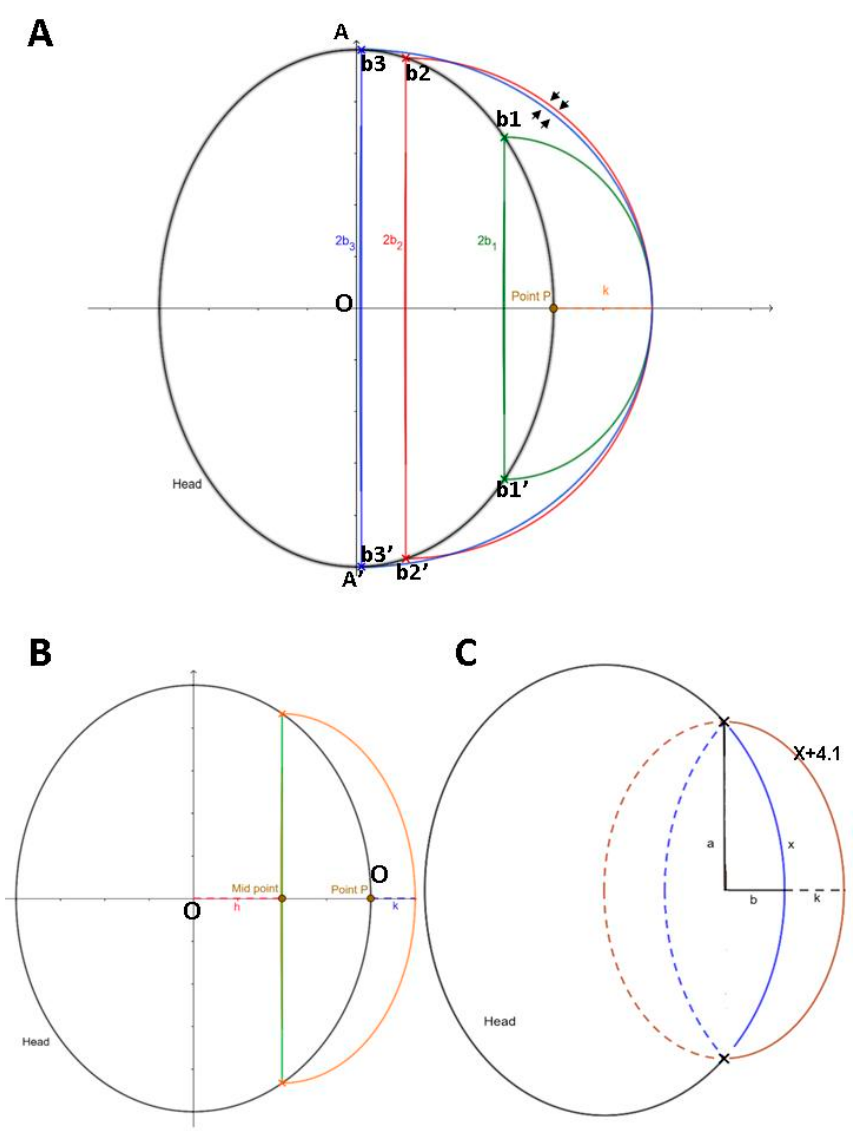
Figure 5. Schematic diagrams of ellipses as a proxy of skull following DC procedure. ( A ) When comparing the large (red) with extreme large (blue) extent of DC, the newly increased area under red contour is larger than that of blue contour (indicated by arrows). ( B ) Schematic diagram of